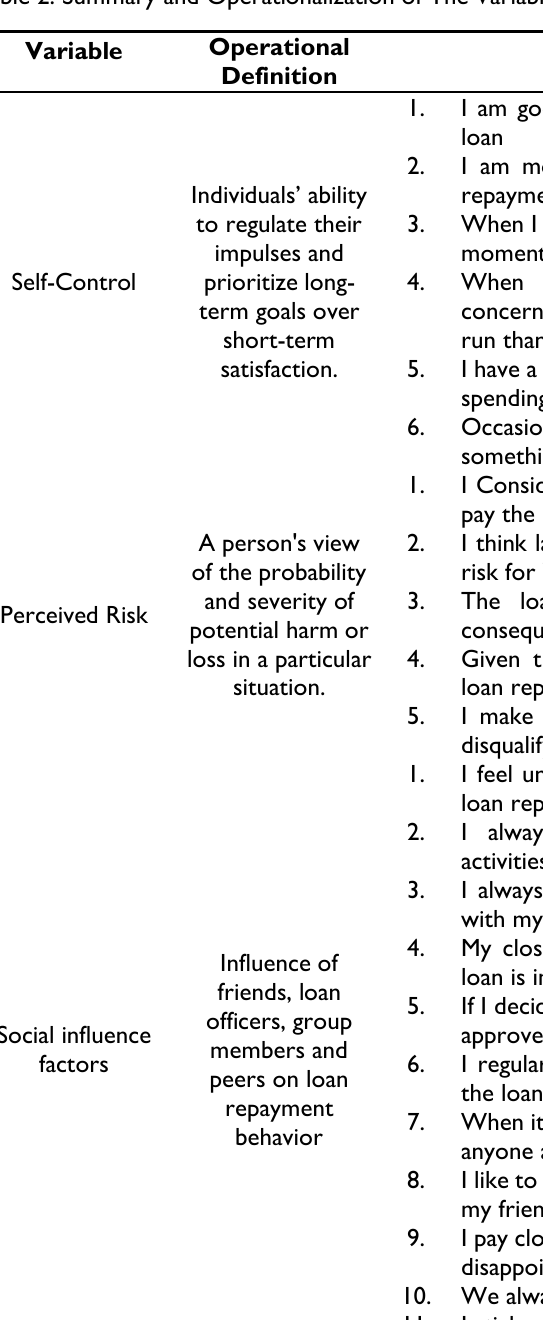
Table 2. Summary and Operationalization of The Variable Variable Operational Definition